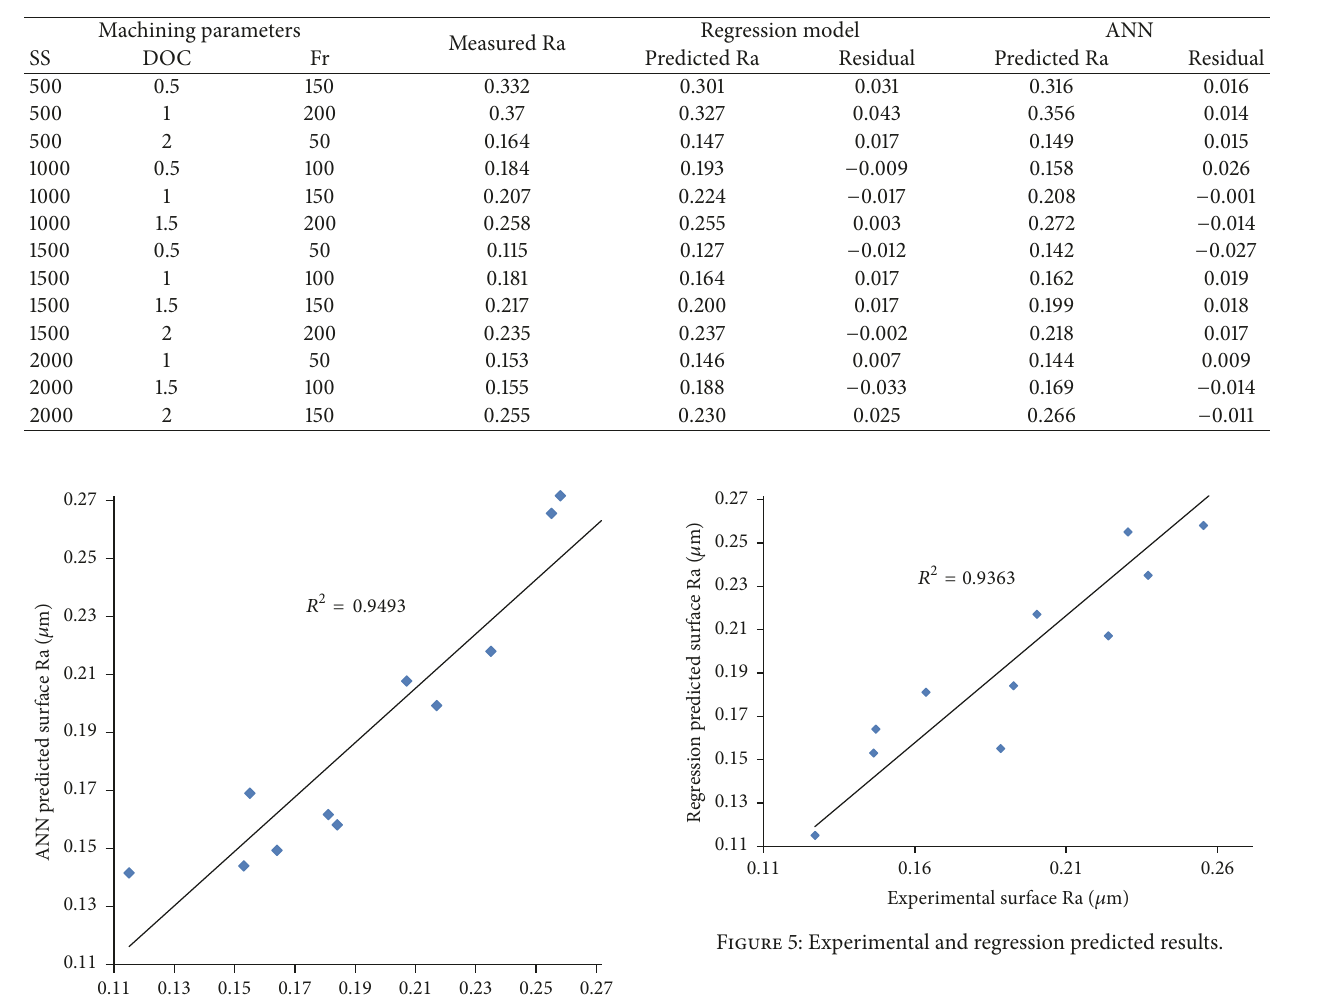
Table 3: Comparison between regression model and ANN predictions.